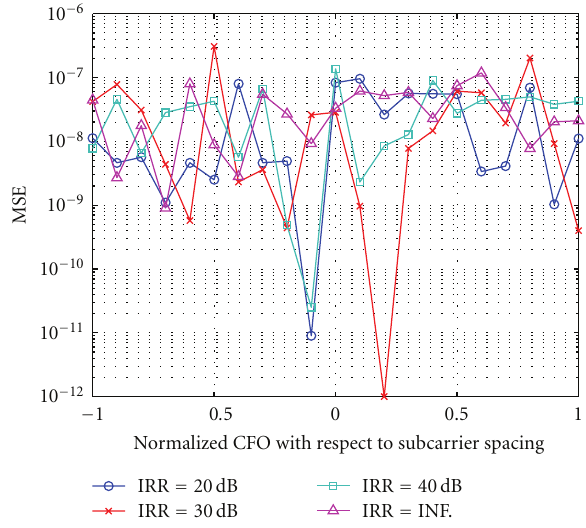
Figure 7: MSE of preamble pilot-based CFO estimator versus normalized CFO for 64-QAM OFDM syste; 39-tap veh. A channel model; ensemble average of 500 independent channel realizations.